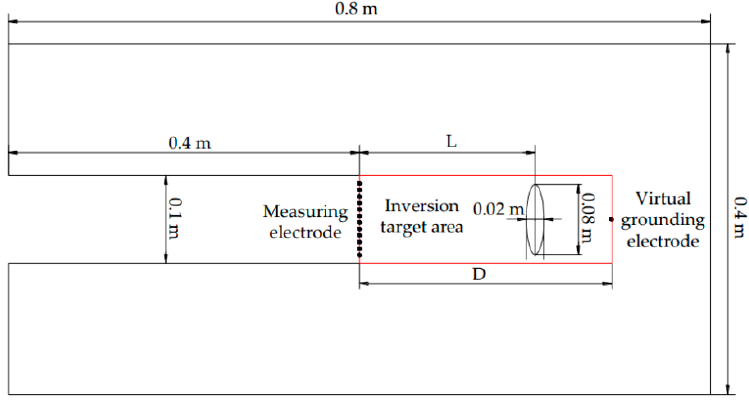
Figure 7. Schematic diagram of virtual grounding electrode model.